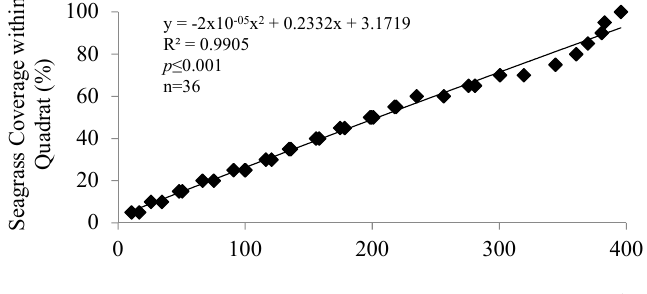
Figure 9. Relationship between STAGB from ground sampling and seagrass coverage (%).